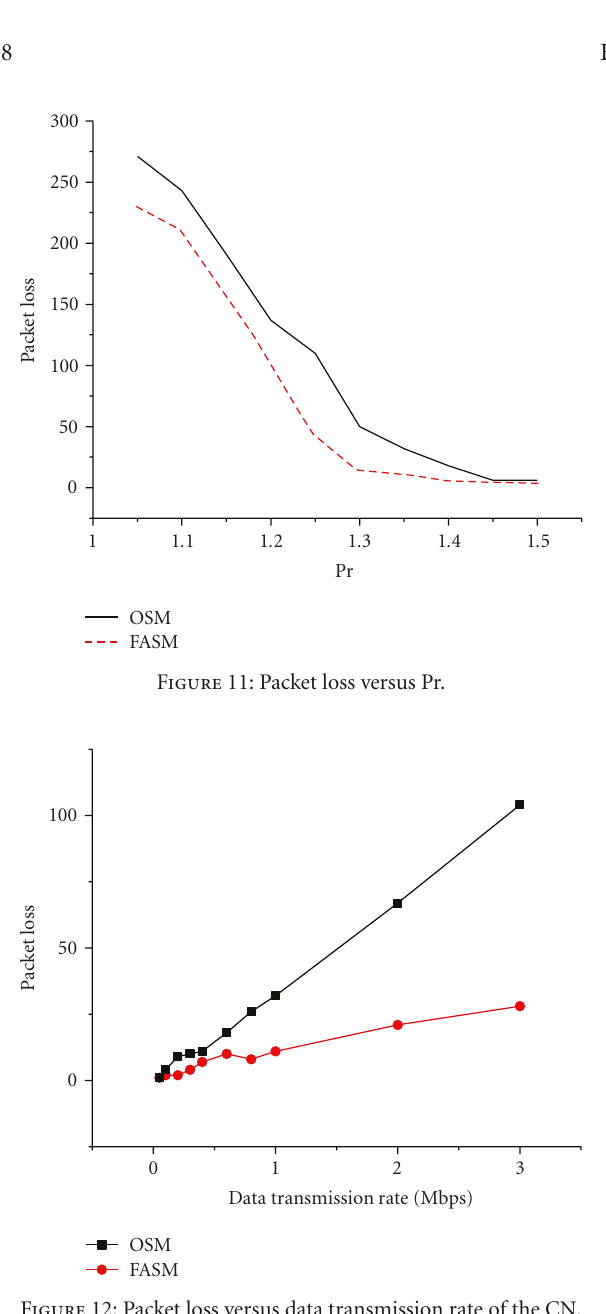
Figure 12: Packet loss versus data transmission rate of the CN.